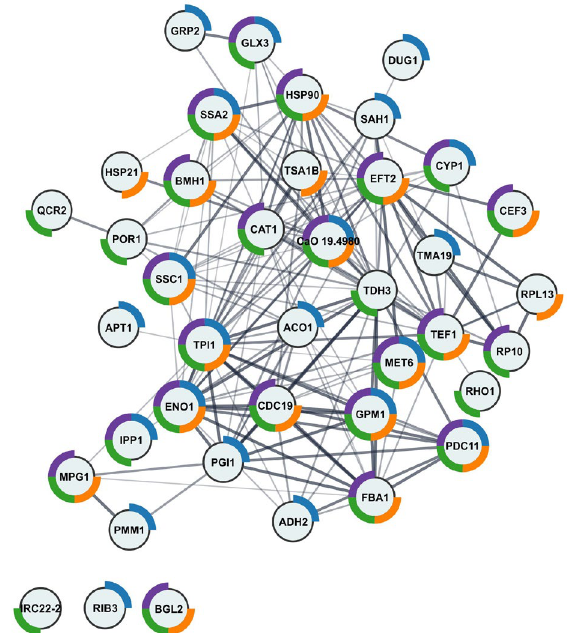
Figure 7. Graphical representation of the results of the functional analysis and the interaction network obtained using the STRING server for Candida proteins bound by the AAF fraction. The colors represent as follows: blue—fungal biofilm matrix, purple—fungal-type cell wall, green—cell periphery, orange—cell surface.